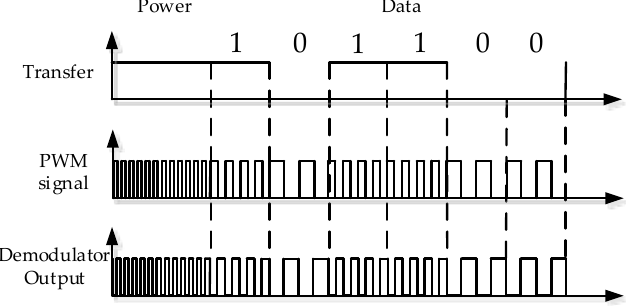
Figure 9. Modulation waveform of data backward transmission.